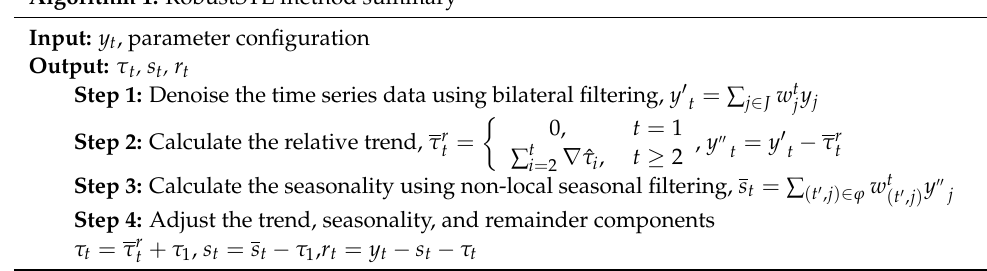
Algorithm 1. RobustSTL method summary